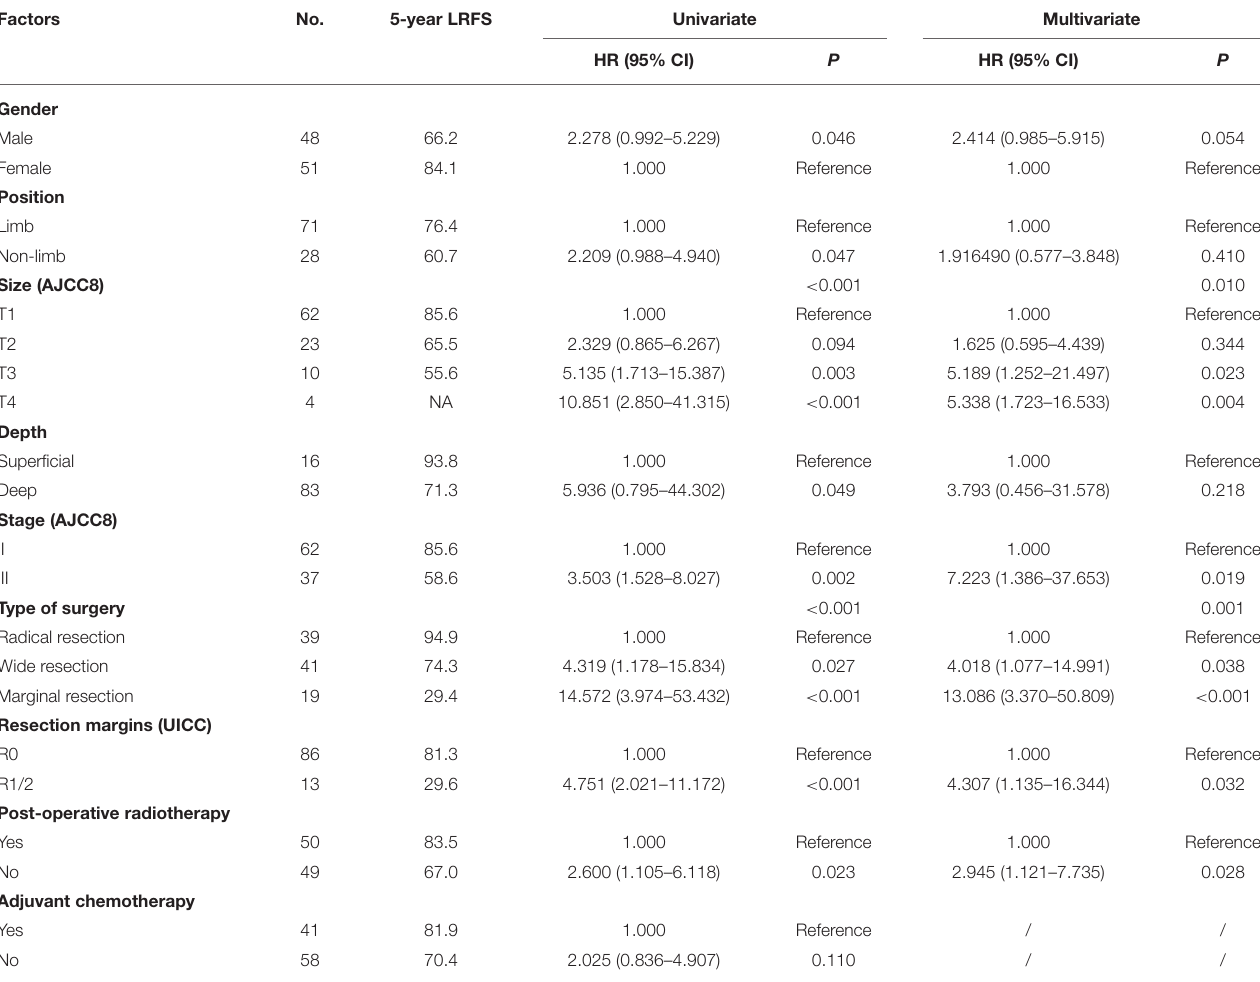
TABLE 4 | LRFS in 99 patients with synovial sarcoma without history of recurrence, as determined with univariate and cox multivariate analyses. Factors No. 5-year LRFS Univariate